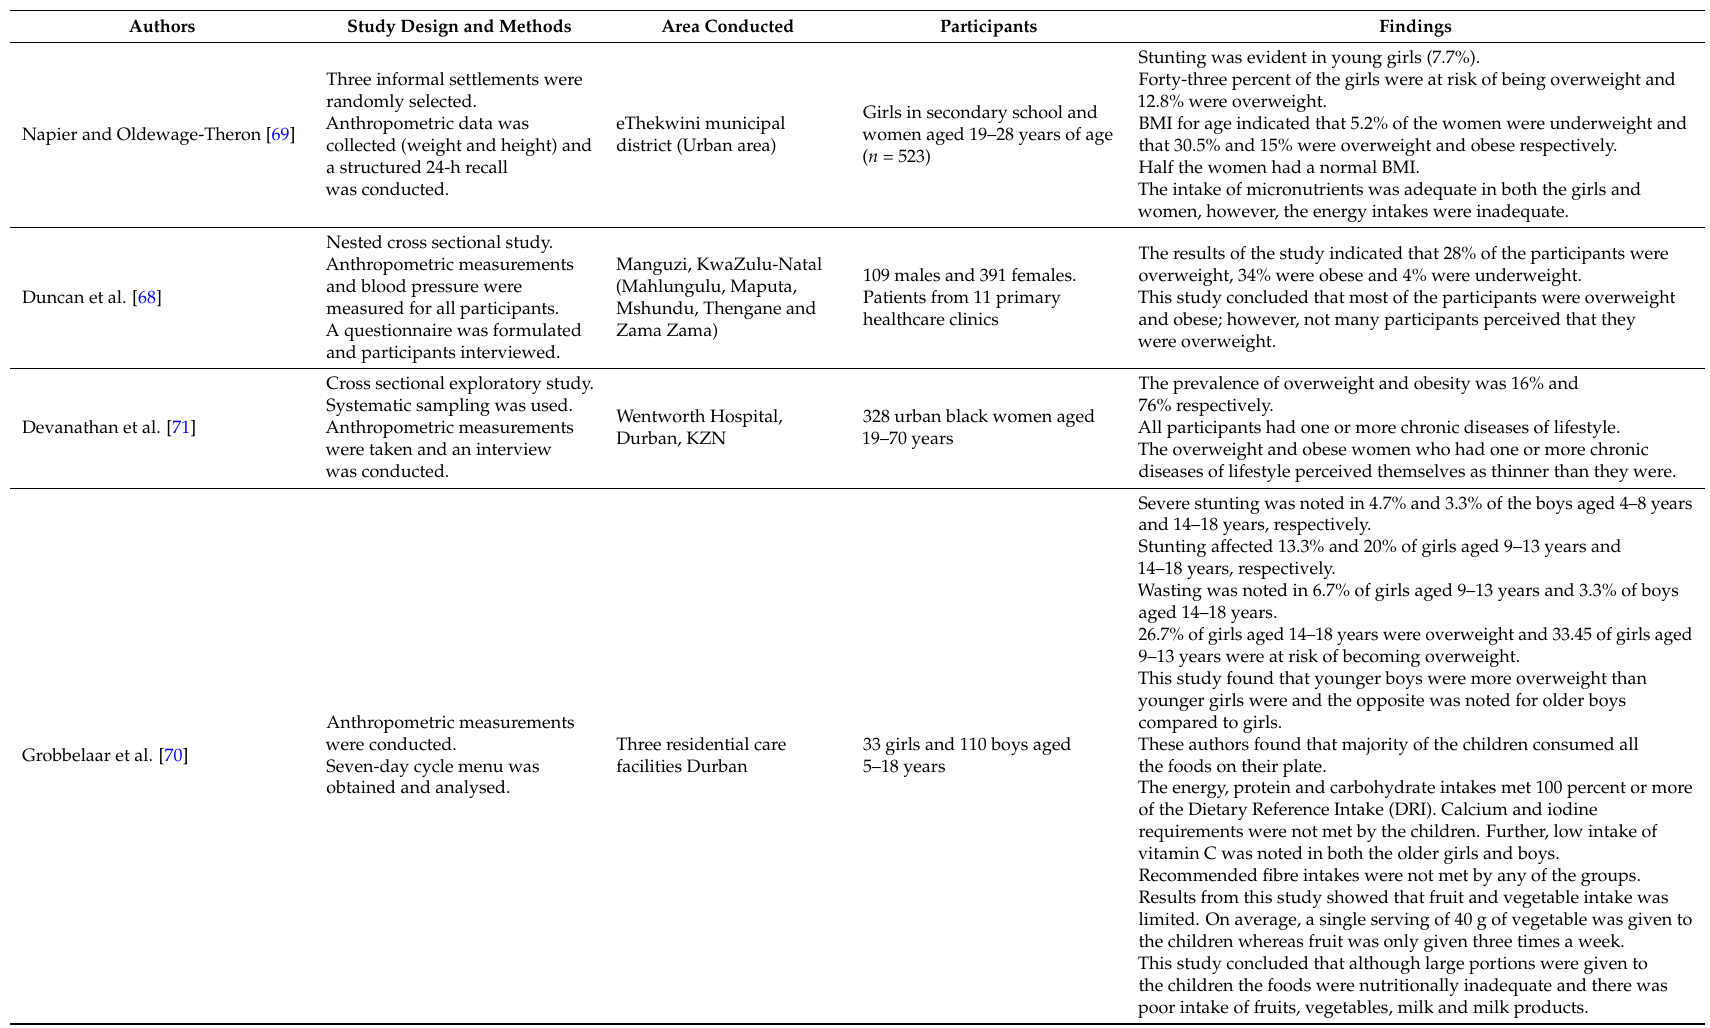
Table 3. Studies conducted to assess the nutritional status of the KZN